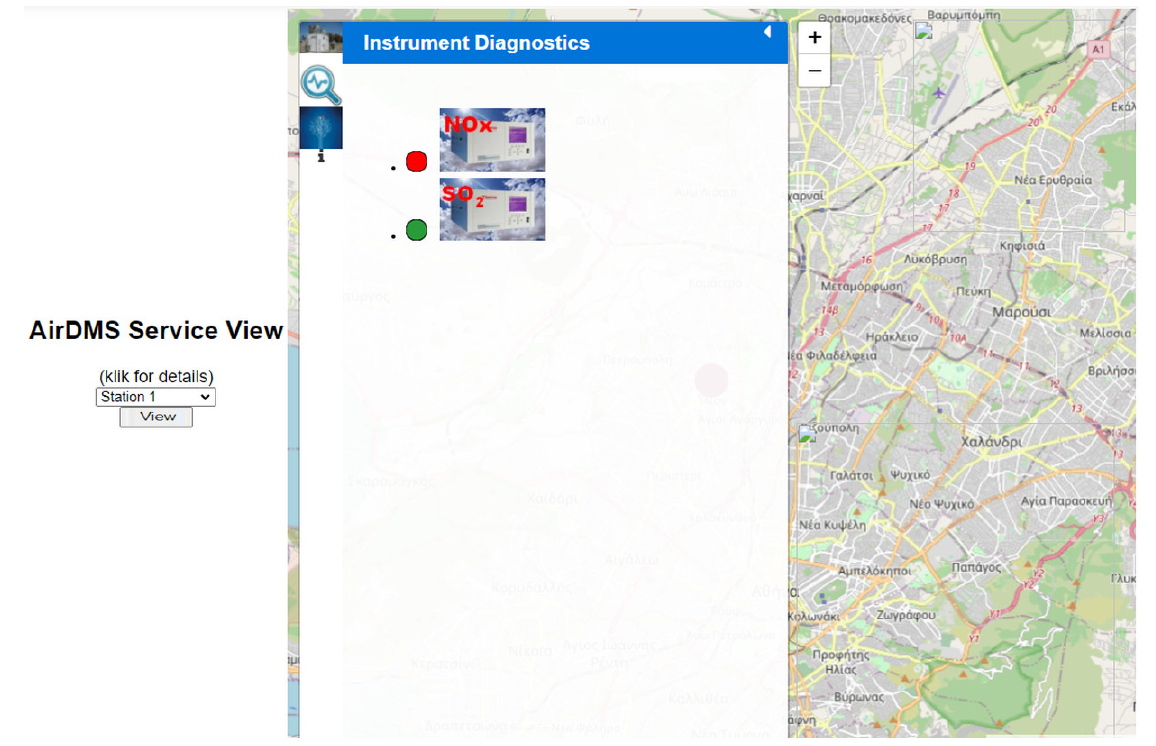
Figure 10. Operating status for analyzers of selected station.